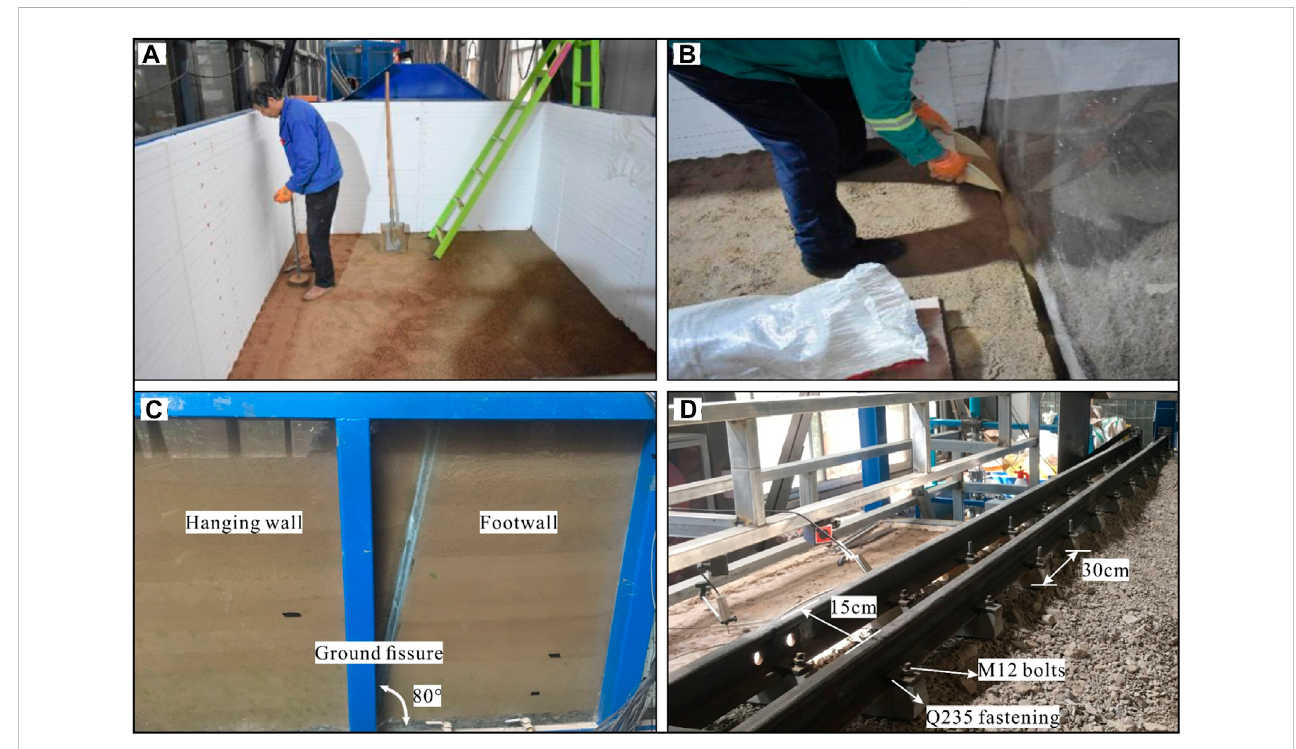
FIGURE 5 Process of model making. (A) compacting the foundation soil; (B) fi lling sand in fi ssure; (C) model side view; (D) model sleeper arrangement.